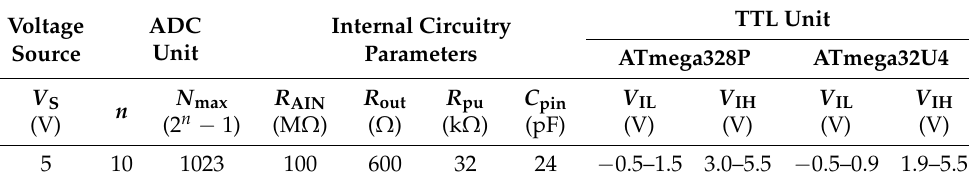
Table 1. Typical values of the operational voltage of the circuits ( V S ), the ADC unit, the internal circuitry to each I/O port and the TTL unit to each AVR ® micro-controller